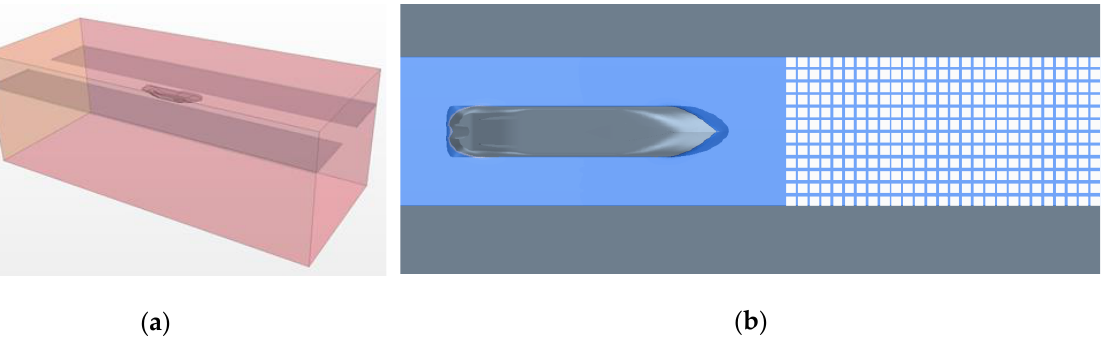
Figure 3. Schematic diagram of the computational domain; ( a ) Schematic diagram of the computa- tional domain at the initial stage; ( b ) the layout of the ice field with an ice concentration of 60%. Table 2 lists the boundary conditions of the computational domain. The boundary to the right is set as the velocity inlet, while the boundary to the right is the outlet. The other surrounding boundary surfaces are set as slip wall conditions. The hull surface and the sides of the ice field are set as non-slip wall conditions. The air inlet is set as the velocity inlet boundary. Table 2. The boundary conditions of the computational